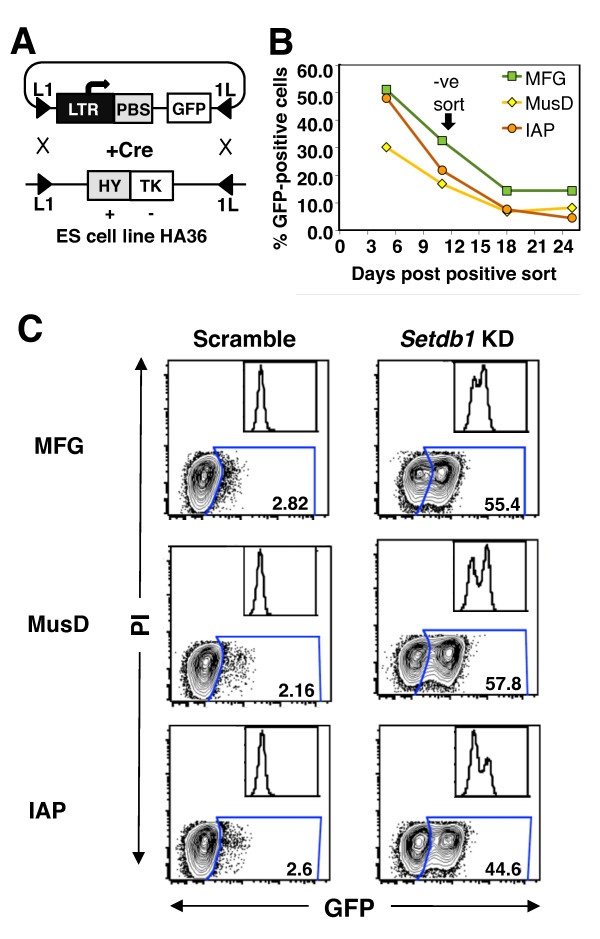
Silencing kinetics and reactivation of ERV reporters integrated in a specific genomic site. (A) Scheme for targeting of ERV reporters into a specific genomic site in mESCs via recombinase-mediated cassette exchange (RMCE). The mESC line HA36 contains a hygromycin B and herpes simplex virus thymidine kinase (HyTK) cassette between inverted Lox sites (L1 and 1L). MFG-green fluorescent protein (GFP), MusD-GFP and IAP-GFP proviral reporter cassettes, which contain the Moloney murine leukaemia virus, MusD (approximately +130 bp of downstream sequence) and IAP (approximately +450 bp of downstream sequence) LTRs, respectively, flanked by L1 and 1L sites, were cotransfected into the HA36 line with a Cre recombinase expression vector. Negative selection with ganciclovir eliminated cells with the original HyTK cassette, yielding pools of cells harbouring the proviral reporter cassettes predominantly integrated at the same site. (B) The kinetics of silencing of the MFG, MusD and IAP cassettes after reactivation of the RMCE pool with siRNA against Setdb1 are shown. (C) GFP-negative cells were sorted at day 12 postinduction with Setdb1 siRNA. Robust reactivation of GFP } expression from each of these pools of cells was observed upon secondary Setdb1 knockdown (KD). Flow cytometry data are presented as contour plots and histograms of 10,000 viable (propidium iodide (PI)-negative) cells.